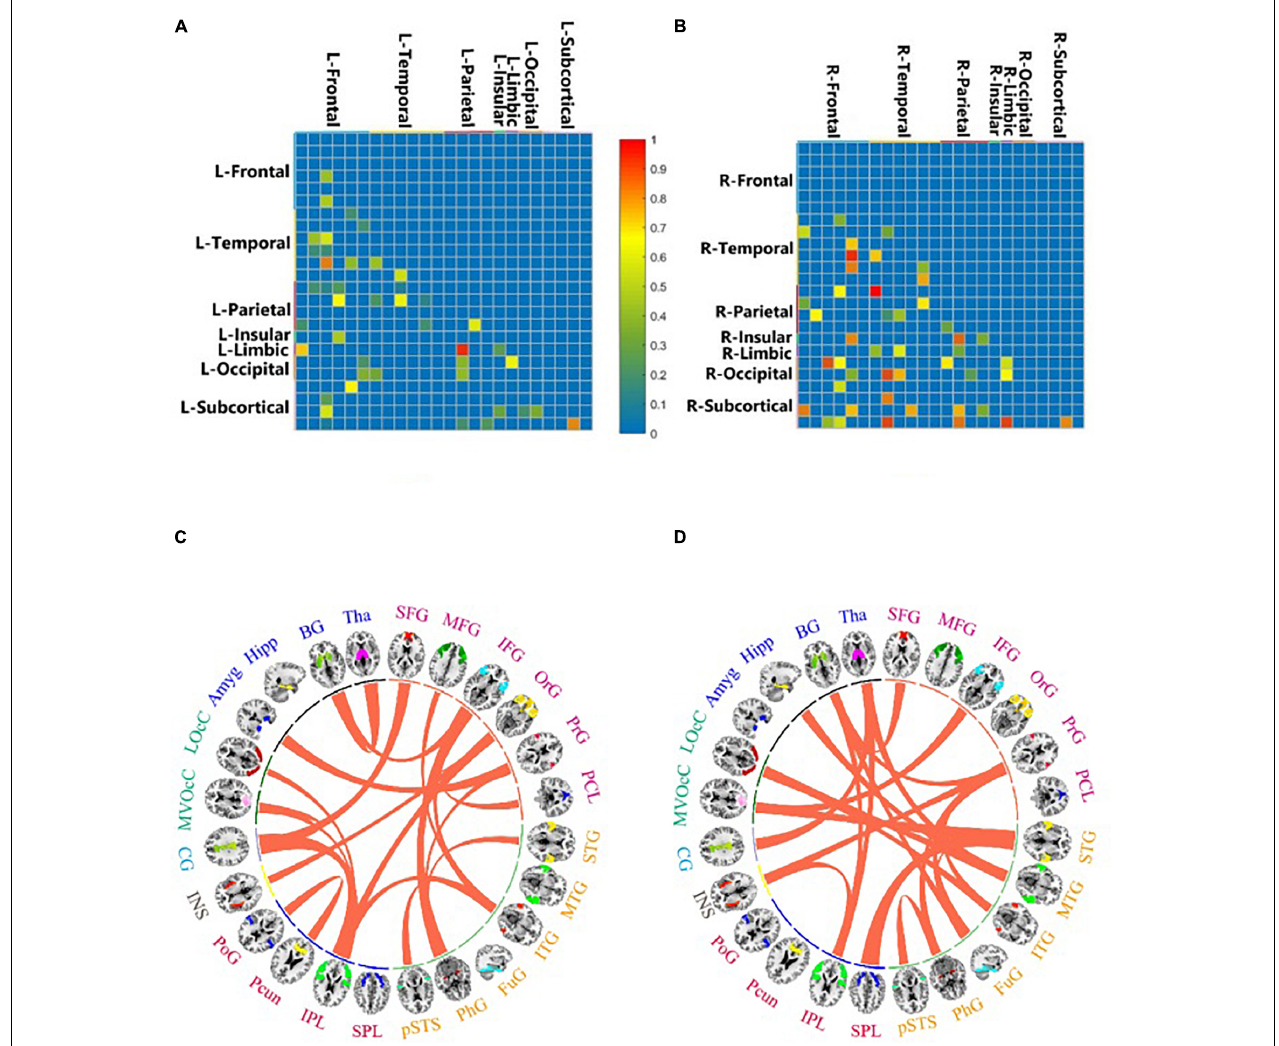
FIGURE 3 | Important brain connections by feature selection of LH (A,C) and RH (B,D) . The value is the important connection corresponding to the important feature selected by random forest. It ranges from 0 to 1, which is proportional to the importance of the brain connection. Important brain connections by prediction of LH (C) and RH (D) . This value is the important connection obtained by using the Ridge model for prediction. The important connections between 24 brain areas are connected by curves.